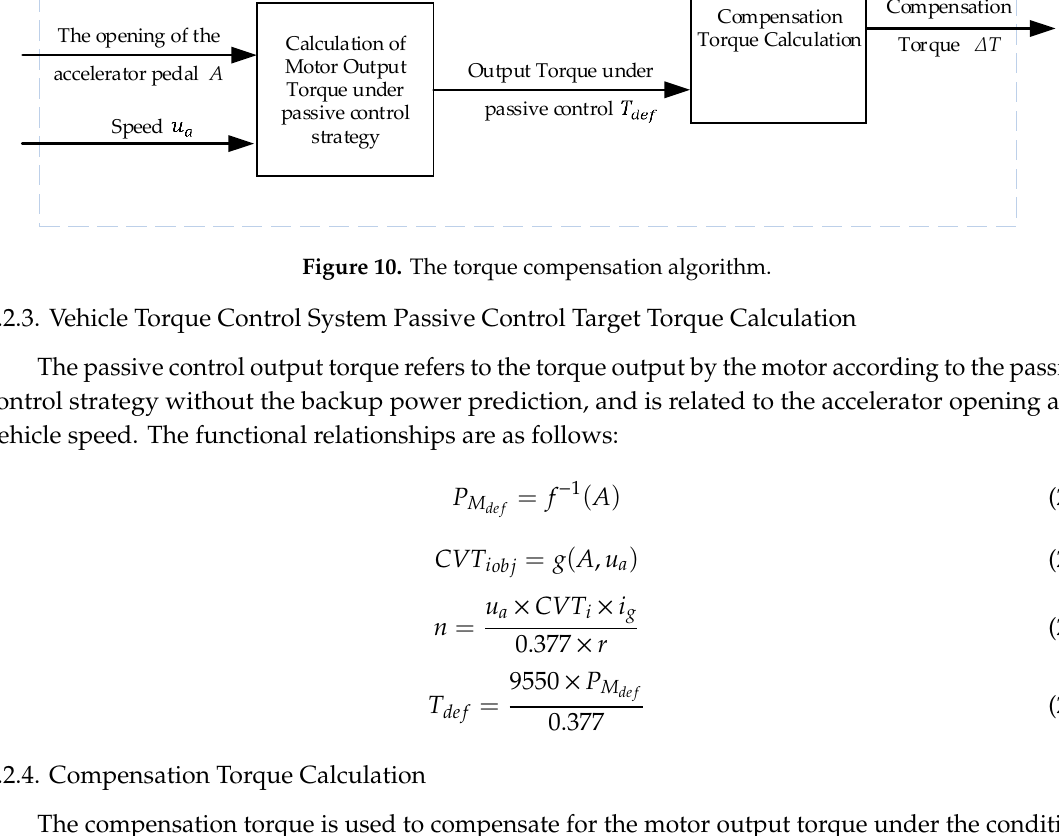
11 of 20 Figure 8. The membership functions: ( a ) Expected acceleration 𝑑𝑣 𝑛 (𝑡) 𝑑𝑡 (𝑚/𝑠 2 ) ; ( b ) Acceleration pedal opening change rate (1/𝑠 2 ) ; ( c ) Compensation power coefficient. Figure 9. The transfer function. Table 1. The fuzzy rule description. Expected Acceleration